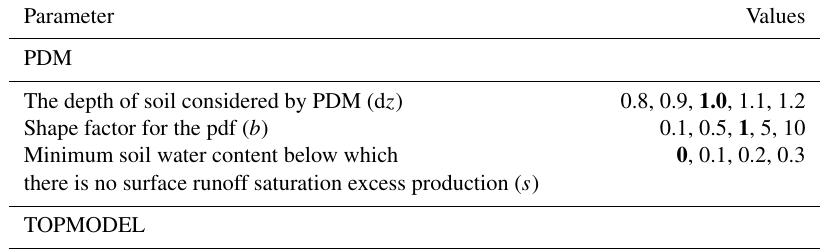
Table 1. Sensitivity analysis of hydrological parameters using (1) PDM and (2) TOPMODEL. Default parameter values are in bold.